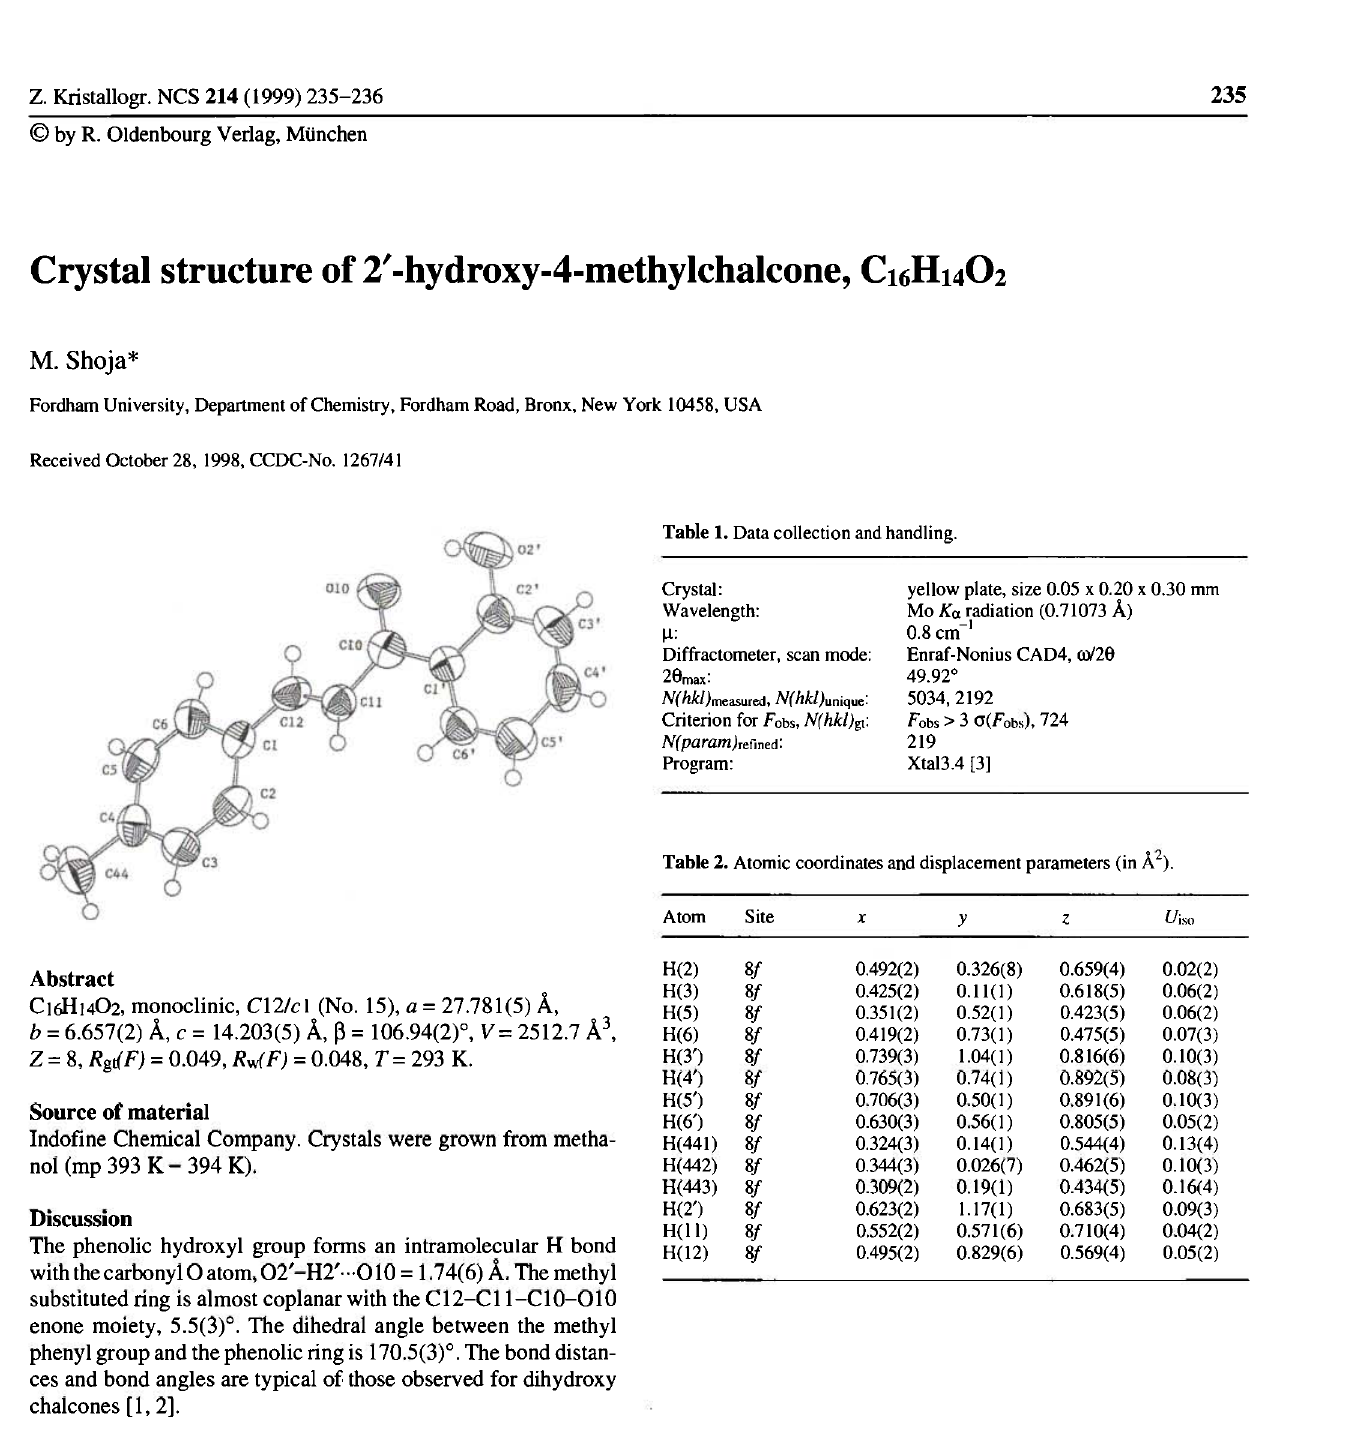
Table 3. Atomic coordinates and displacement parameters (in Ä 2 ).